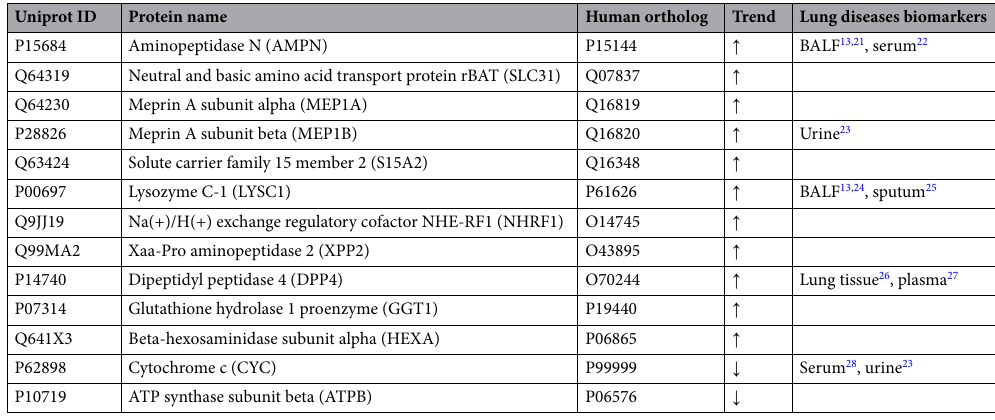
Table 1. The potential urinary protein biomarkers for VILI. ↑ means up-regulated trend, ↓ means down- regulated